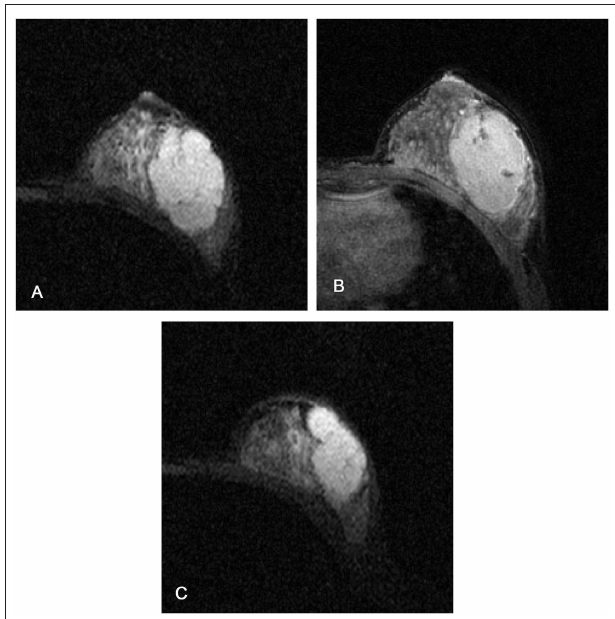
FIGURE 5 | Magnetic resonance images of a 26-year-old female patient with fibroadenomas: (A,C) axial short TI inversion recovery T2-weighted (T2W-STIR), (B) third post-contrast. The texture features on T2W-STIR correctly identified the fibroadenoma which was falsely interpreted as a phyllodes tumor on clinical and conventional MRI features, possibly due to the cystic component, strong lobulation, and